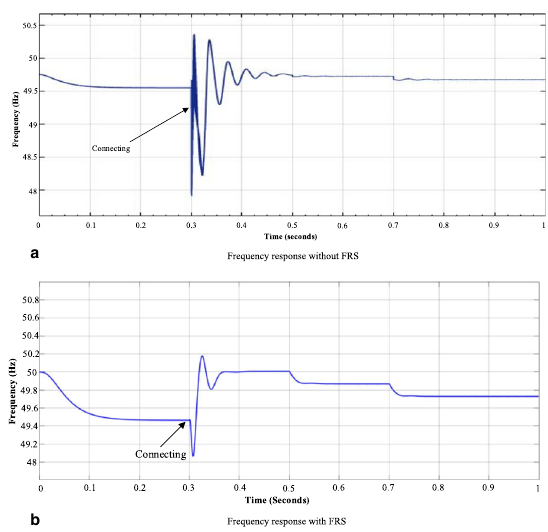
Fig. 12 Frequency variation with and without